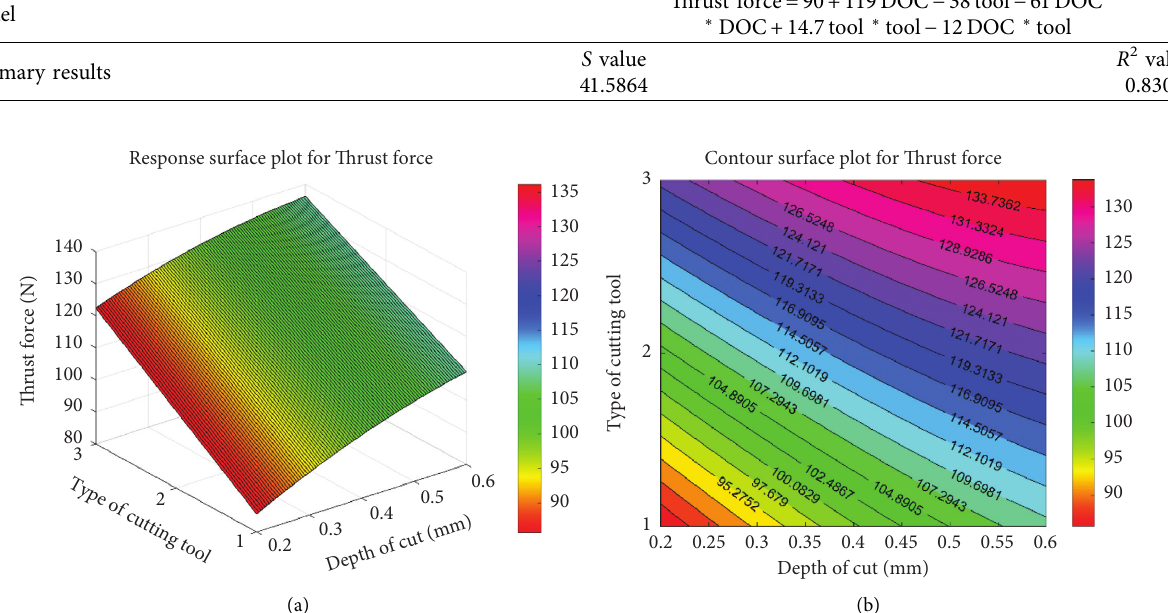
Figure 12: (a) Response surface plot for Thrust force (depth of cut vs. cutting tool type). (b) Contour surface plot for Thrust force (depth of cut vs. cutting tool